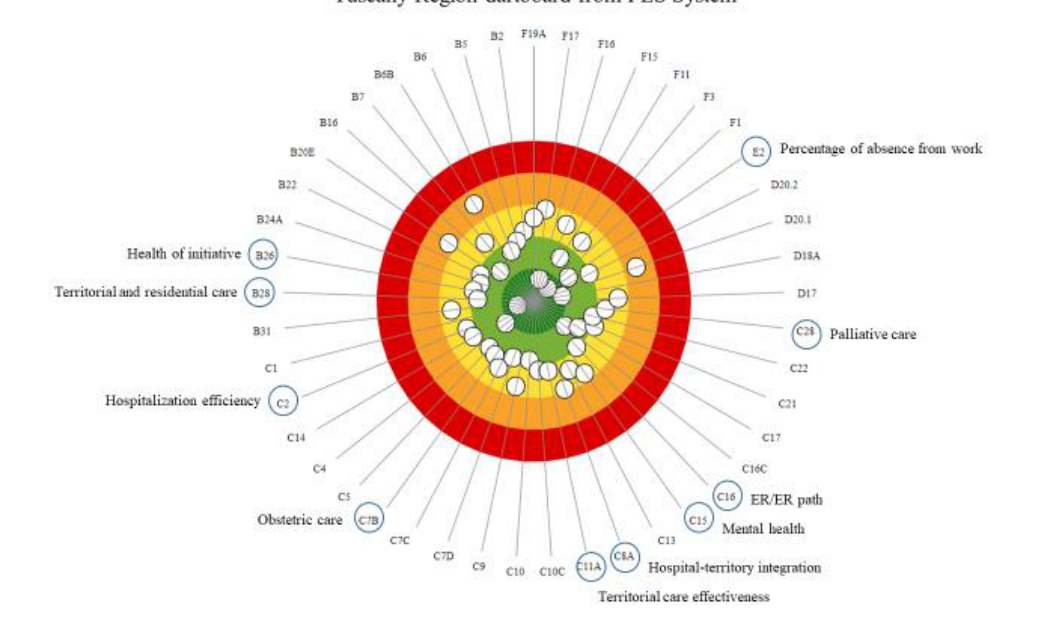
Figure A1. Tuscany Region dartboard.